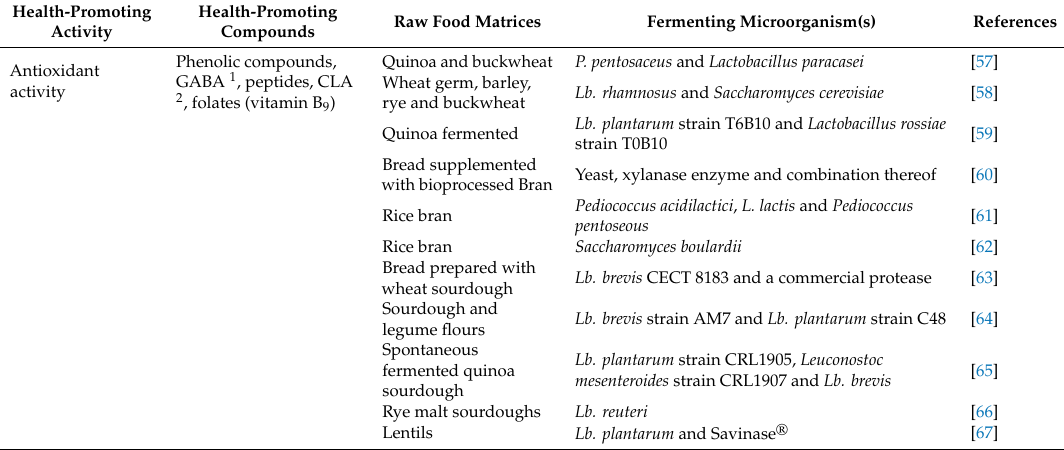
Table 3. Health-promoting compounds in fermented grain-based